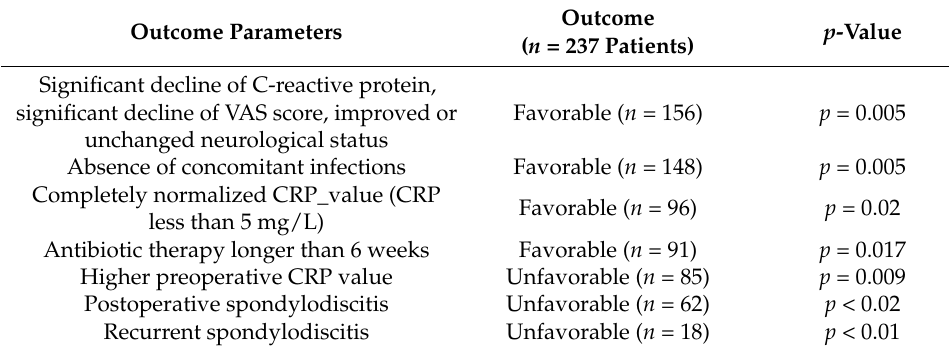
Table 7. Outcome